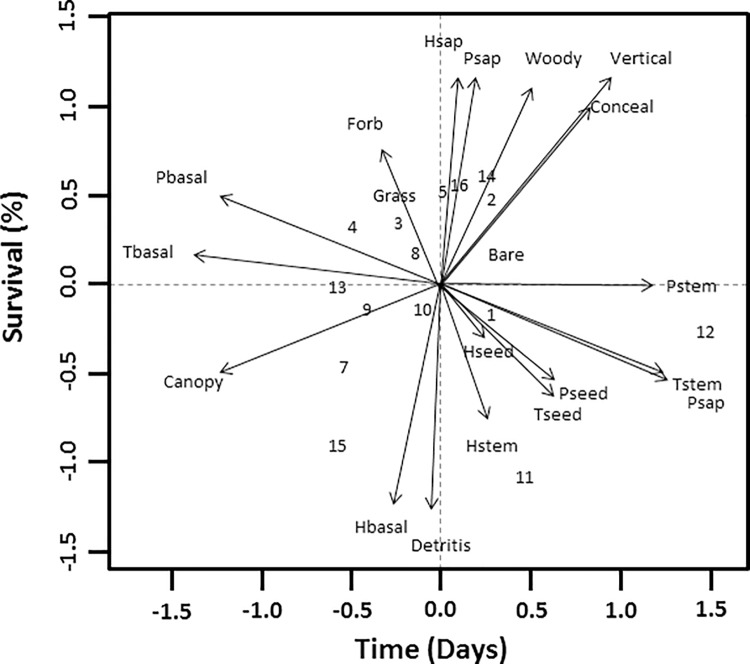
Distance biplot of initial principal components analysis with Scaling 1 for site and species scores.Sites scores are weighted sums of species scores and scaled proportional to eigenvalues. Species are un-scaled with weighted dispersion equal on all dimensions. Variables include Basal Area (Total, Pine, Hardwood), Stem Density (Total, Pine, Hardwood), Sapling Density (Total, Pine, Hardwood), Seedling Density (Total, Pine, Hardwood), Concealment, Vertical Structure, Percent Over-story Canopy Cover, and Ground Cover Composition (Graminoids, Forbs, Woody Plants, Bare Ground, and Detritus). Sites: 1–5 represent successful nests, sites: 6–8 represent failed nests and sites: 9–16 represent random plots.